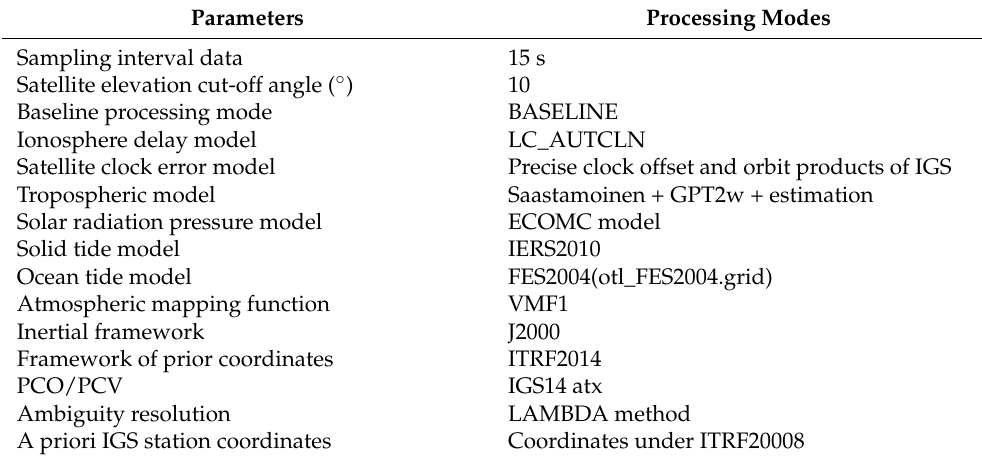
Table 2. The main parameters used in the GAMIT